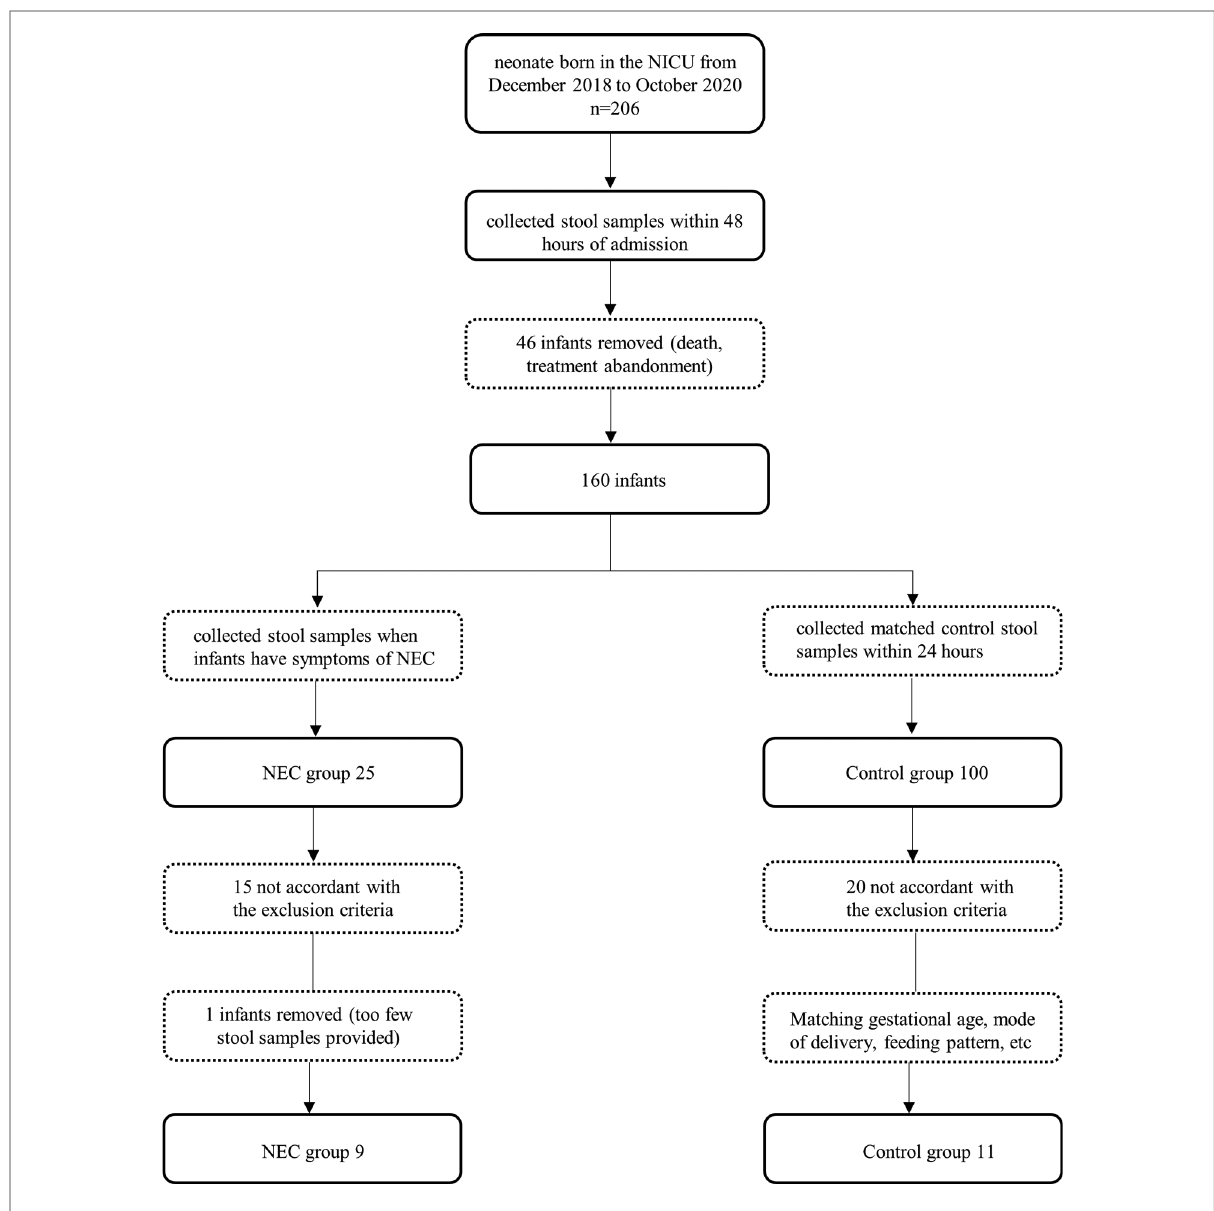
FIGURE 1 Flowchart for screening